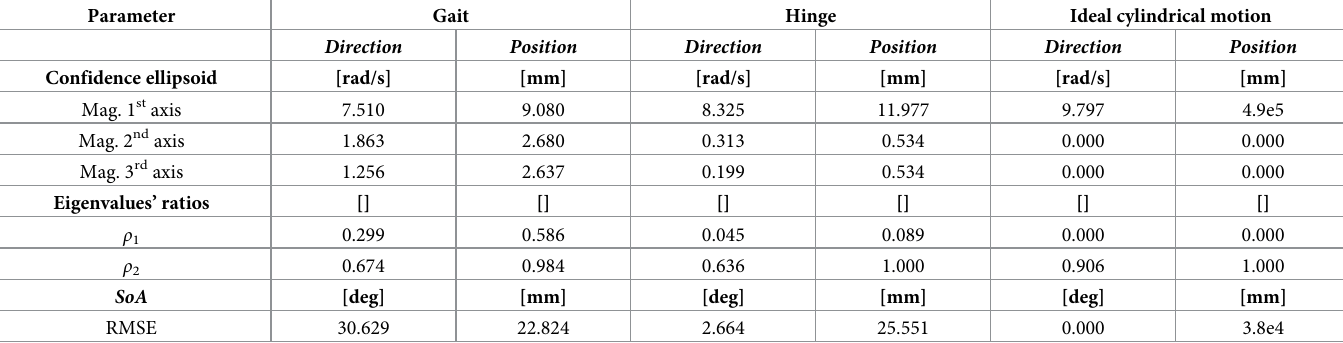
Table 2. Results of the dispersion